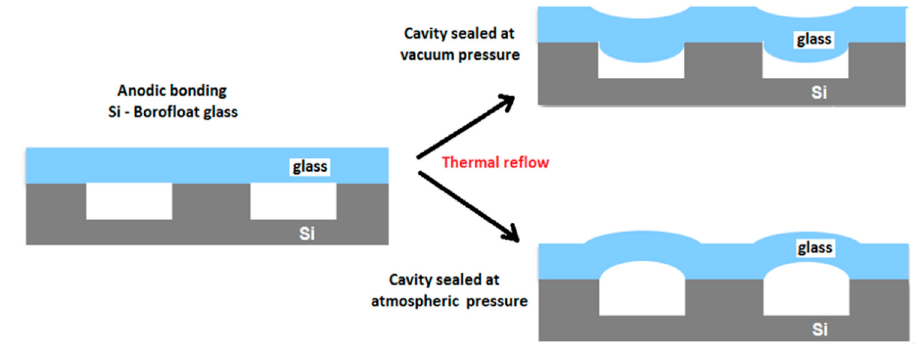
Figure 7. Principle of glass micro-blowing fabrication process. Reproduced with permission from [18], published by SPIE, 2018.